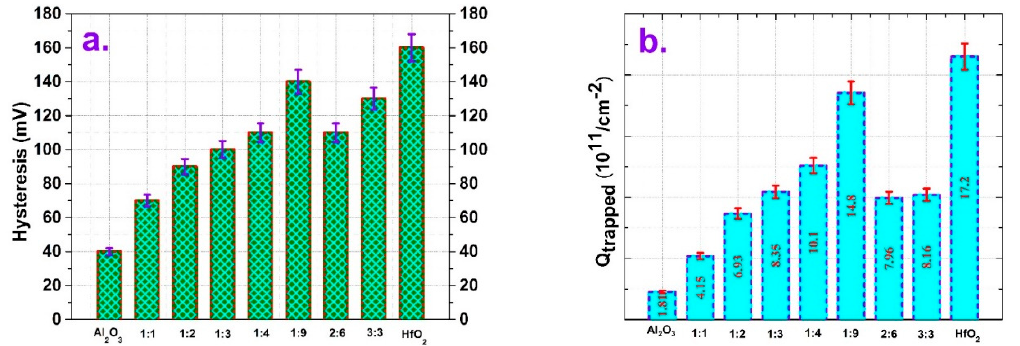
Figure 2. ( a ) Comparison of measured C-V hysteresis of Al / HfAlO / Si MOSCAPs with varying Al content (0–100%) at 1 MHz frequency. ( b ) Surface trapped charge density (from C–V hysteresis) of Al / HfAlO / Si MOSCAPs according to Al 2 O 3 and HfO 2 intermixing ratio.